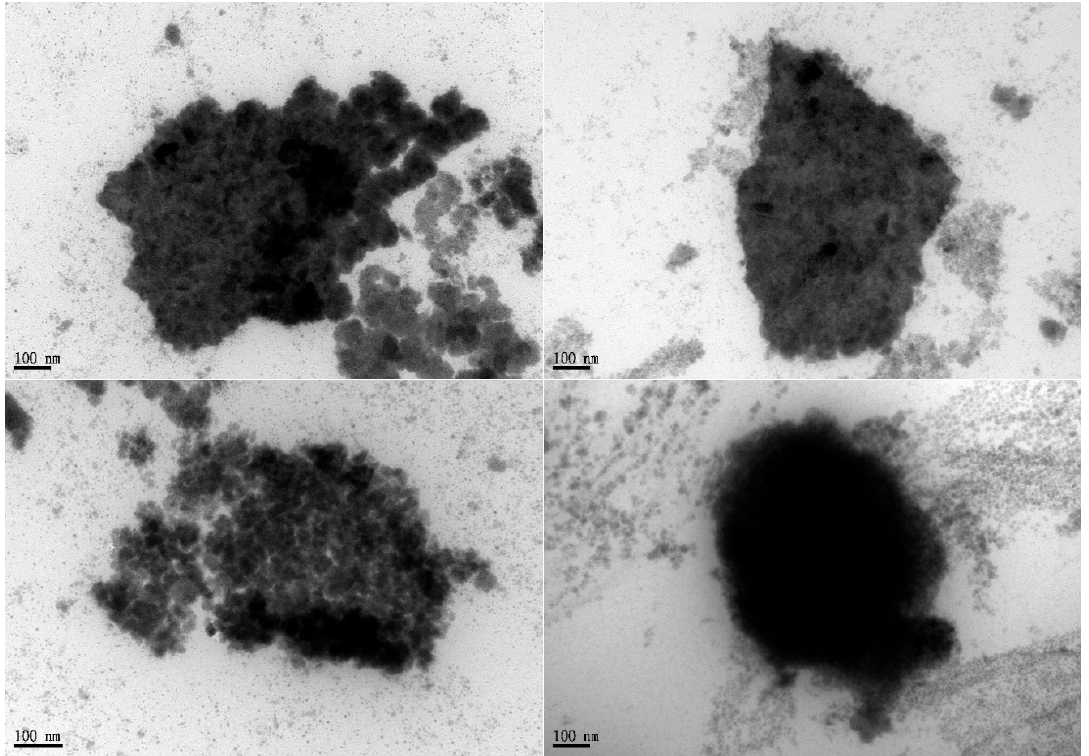
Figure 3. Formulation B represented in various appearances under the observation by TEM. The composition of formulation B was described in Table 1. TEM, transmission electron microscopy; Scale bar = 100nm. Table 2. The stability of selected microemulsion, formulation B loaded with magnolol. (Mean ± SD, n = 3).